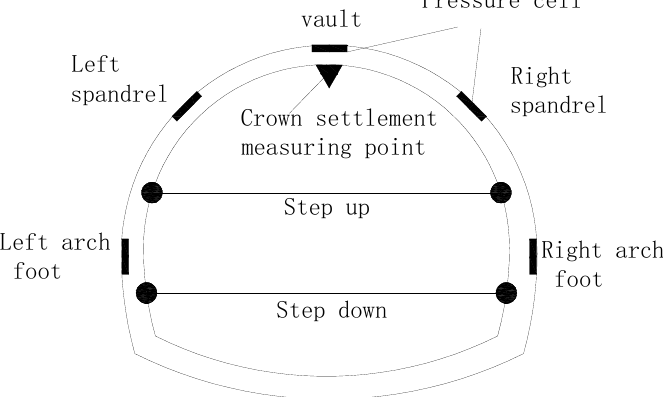
Figure 7. Layout of measuring points of monitoring section.